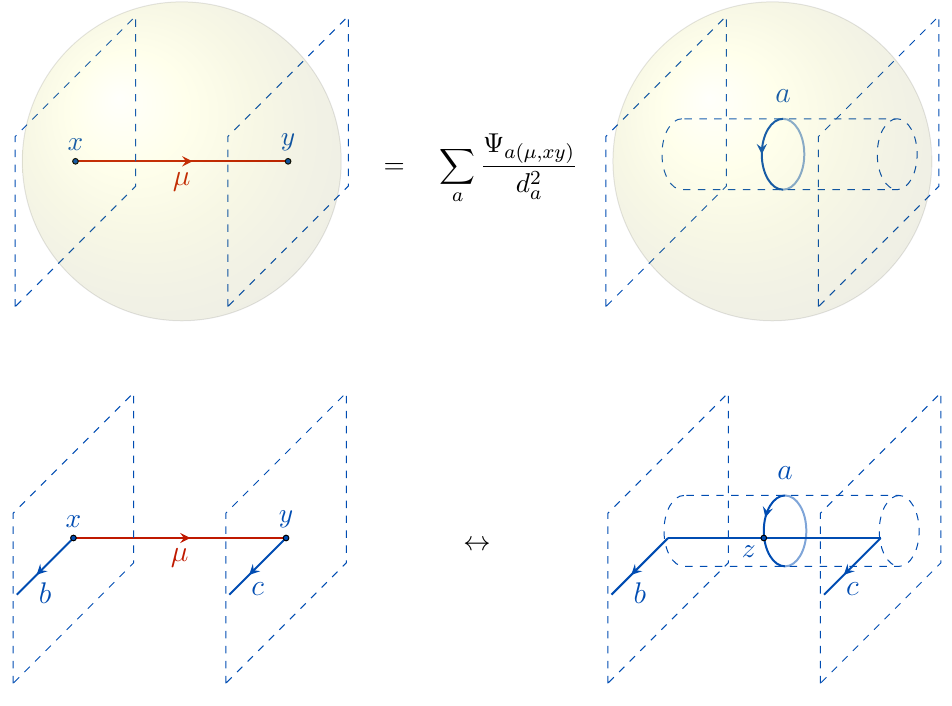
Figure 5 . Boundary crossing relation in 2+1d TQFT. The blue dashed lines sketch the surfaces of the gapped boundaries, such that the regions outside the slabs and inside the cylinders are